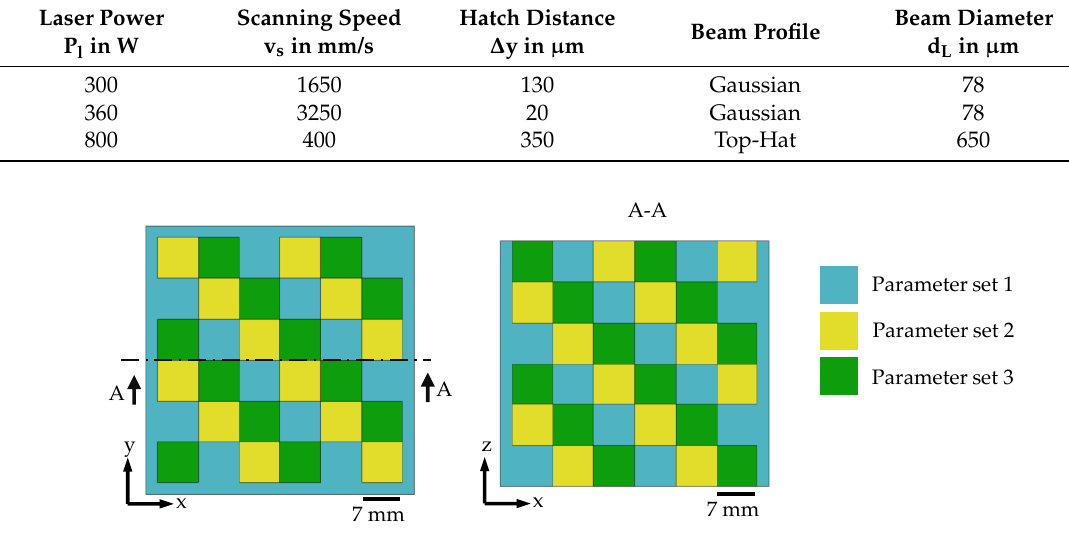
Table 2. Used parameters.